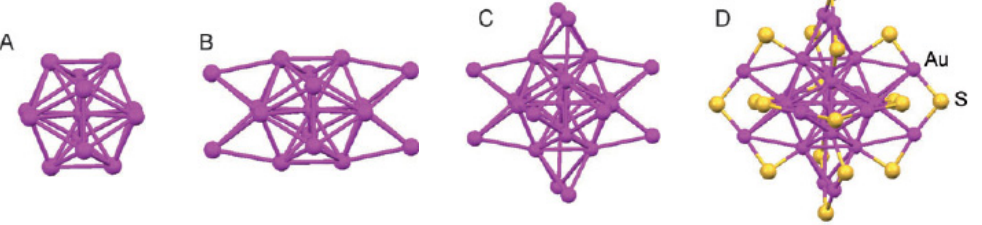
(SR) nanocluster [64]. 25 18